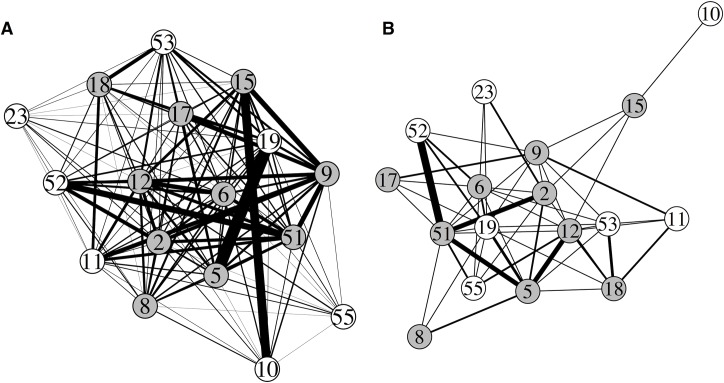
(A) Network constructed from 975 contacts between tagged barn swallows where logs had maximum RSSI values ≥ 0 = proximity < 5m (edges scaled to 1/5). (B) Network constructed from 88 contacts between tagged barn swallows where logs had maximum RSSI values ≥ 40 = proximity < 0.1m.In both cases, n = 17 tagged barn swallows with females in white and males in gray. Data are from 15 hours of logging over three days. Node labels correspond to the bird’s tag ID.